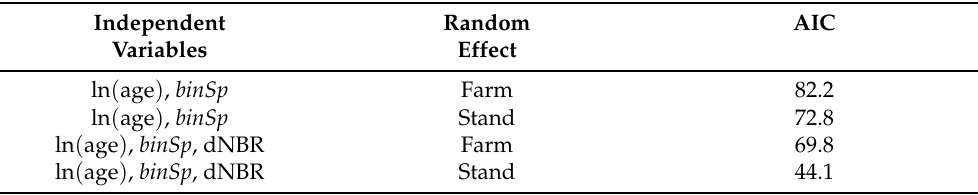
Table 3. Comparison of the quality of the statistical models fitted for the estimation of the combustion factor, its variables, and random